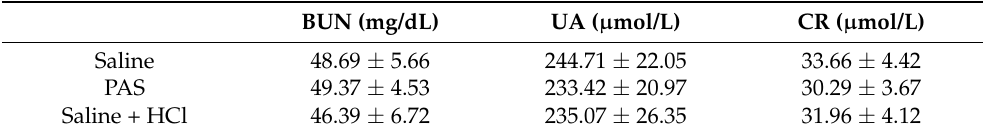
Table 2. Analysis of kidney function.